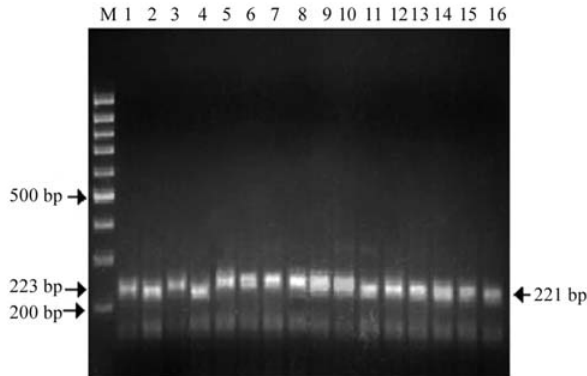
Figure 2 - Distribution of AUDPC of F 6 lines of a cross between resistant (IBON 18) and susceptible (RD 2508) for spot blotch during 2003-2004.